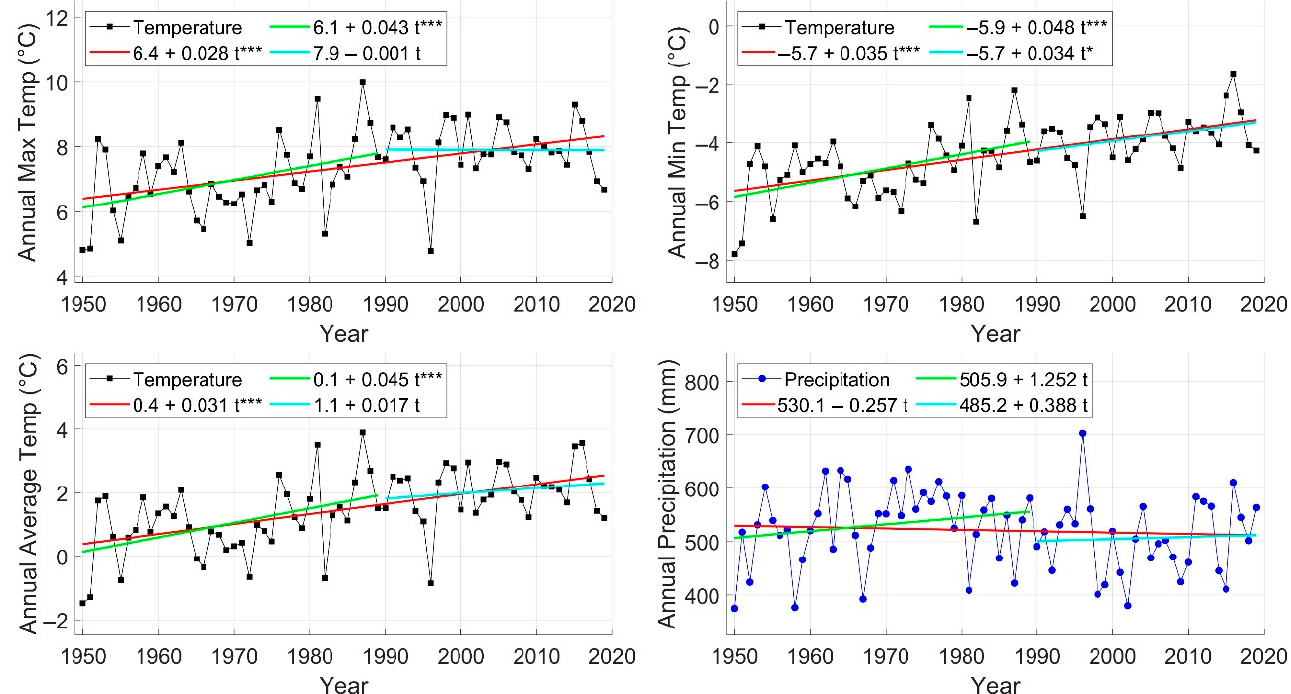
Figure 3. Climate trend analysis results for the lower ARB. The statistically significant slopes are marked by stars: (** = 95%), (*** = 99%).